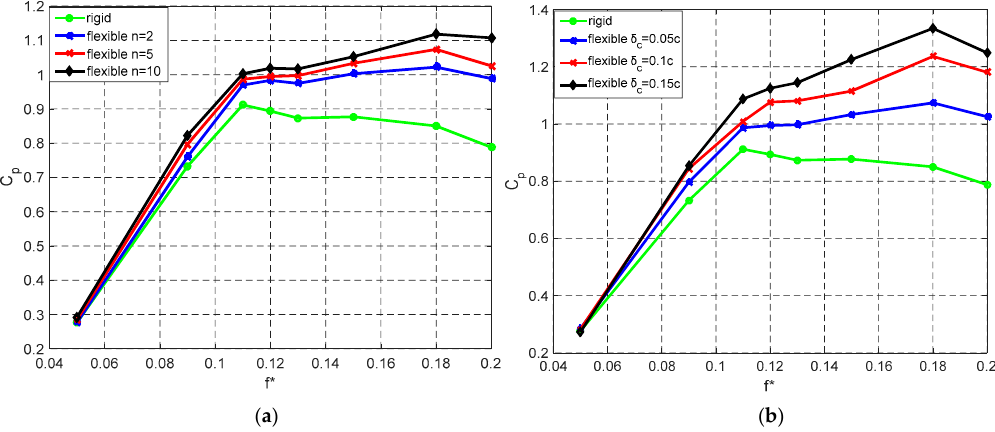
Figure 12. Comparison of average power coefficient among different chord-wise flexible hydrofoil under different reduced frequencies. ( a ) Fixed δ c = 0.05c. ( b ) Fixed n = 5.